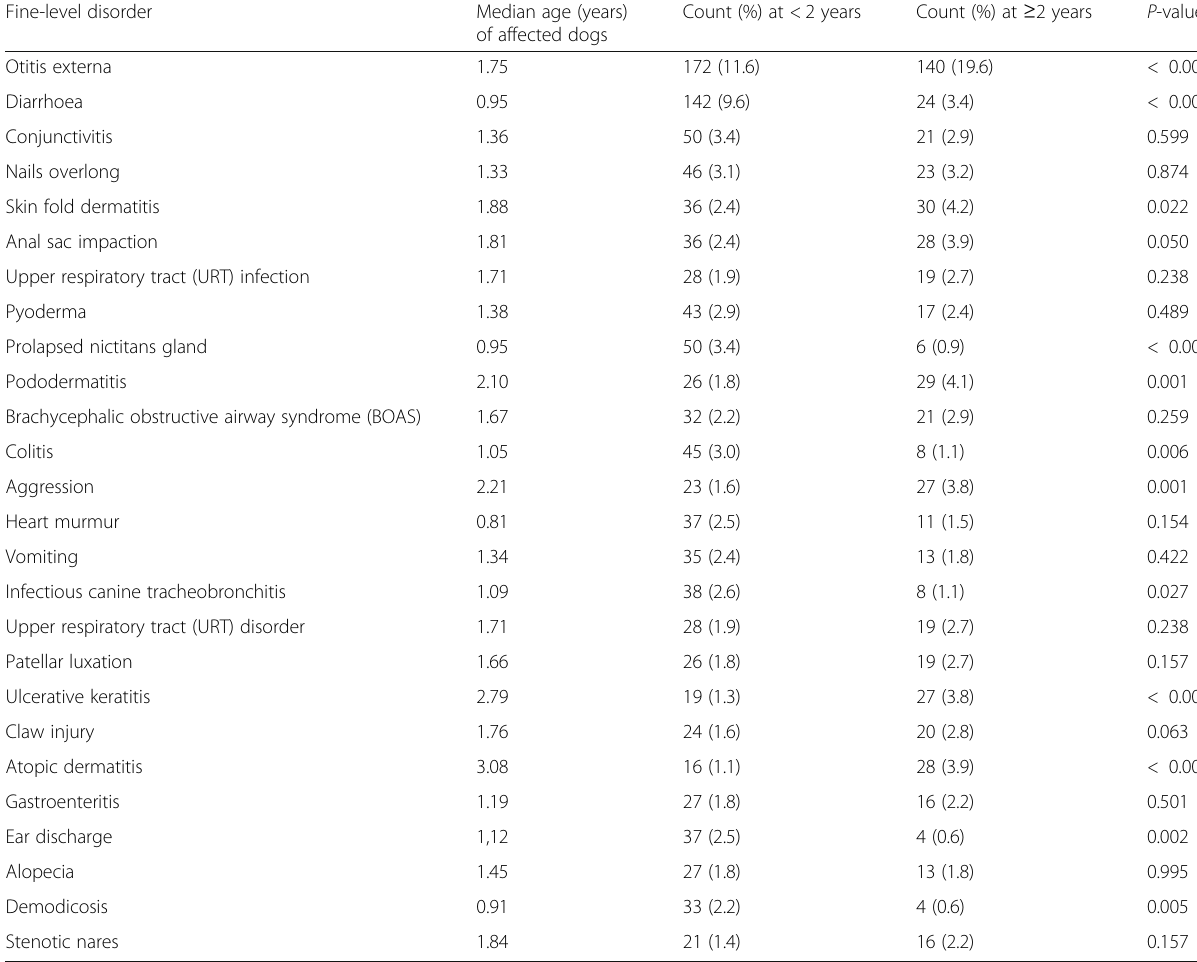
Table 4 Comparison of the prevalence of the most common disorders at a fine-level of diagnostic precision between French Bulldogs aged under 2 years ( n = 1486) and aged at/above 2 years ( n = 714) attending UK primary-care veterinary practices participating in